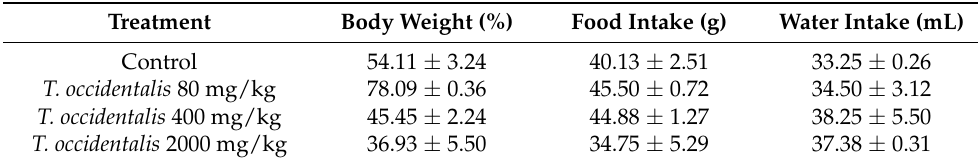
Table 1. Effect of T. occidentalis on weekly change in body weight, food and water intakes of